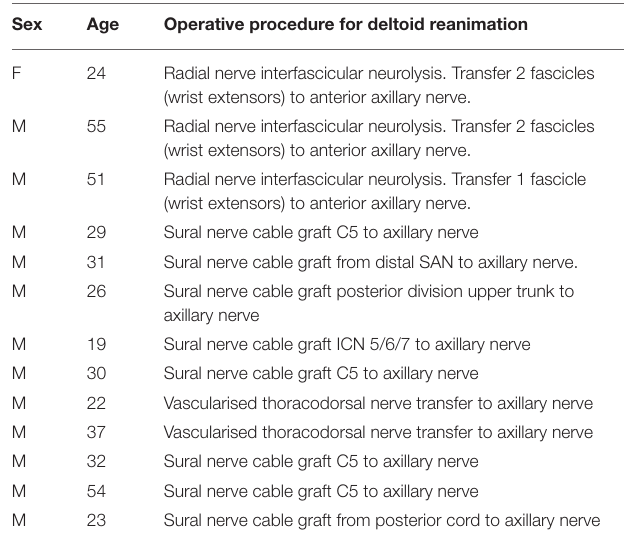
TABLE 2 | Alternative nerve transfers and grafting procedures performed for group 4